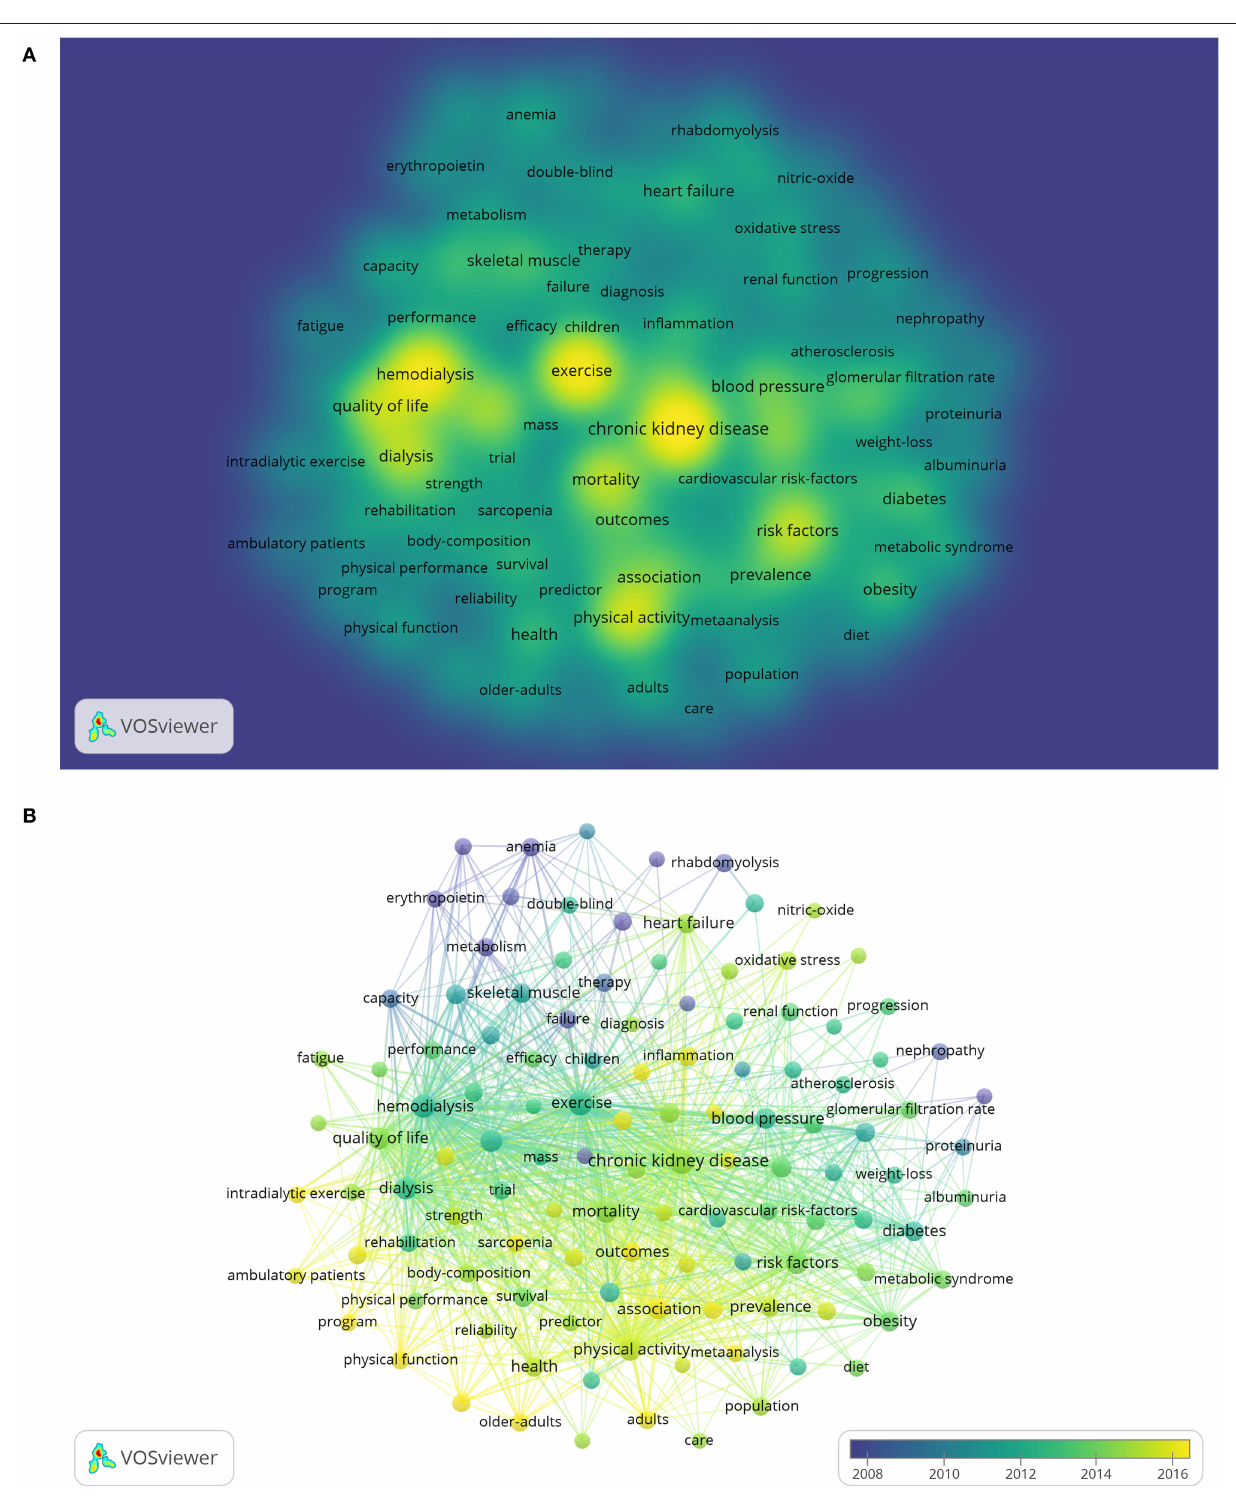
Frontiers in Medicine |